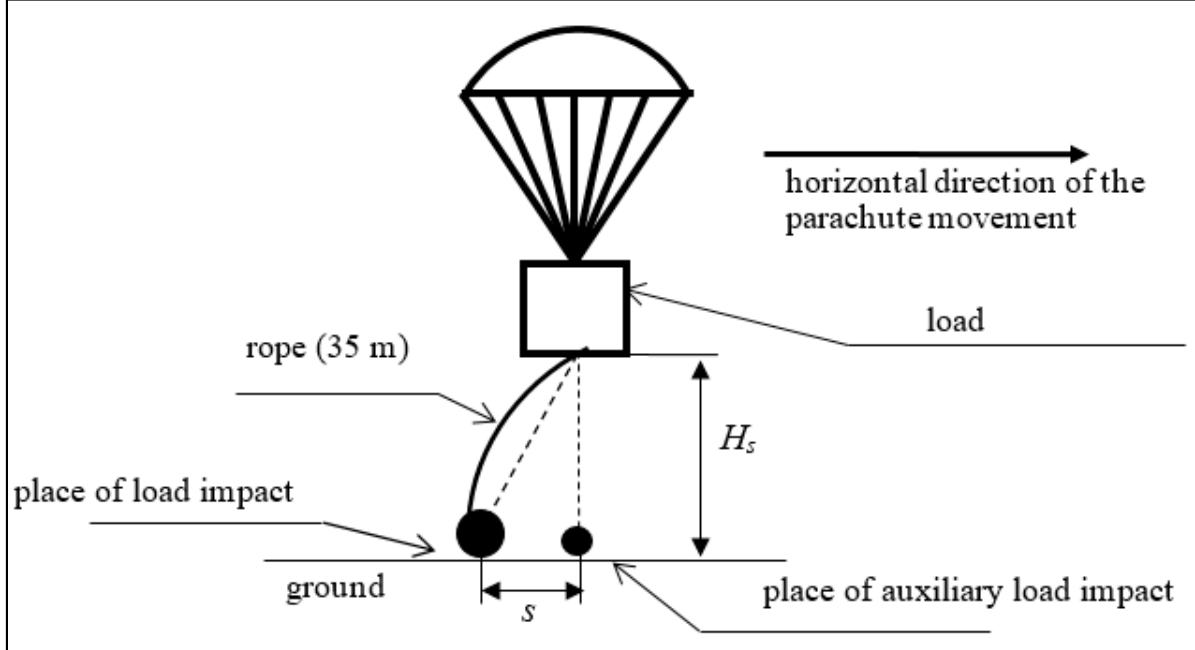
Figure 1. Measurement of the parachute vertical speed using the classic method (source: The authors of this article).